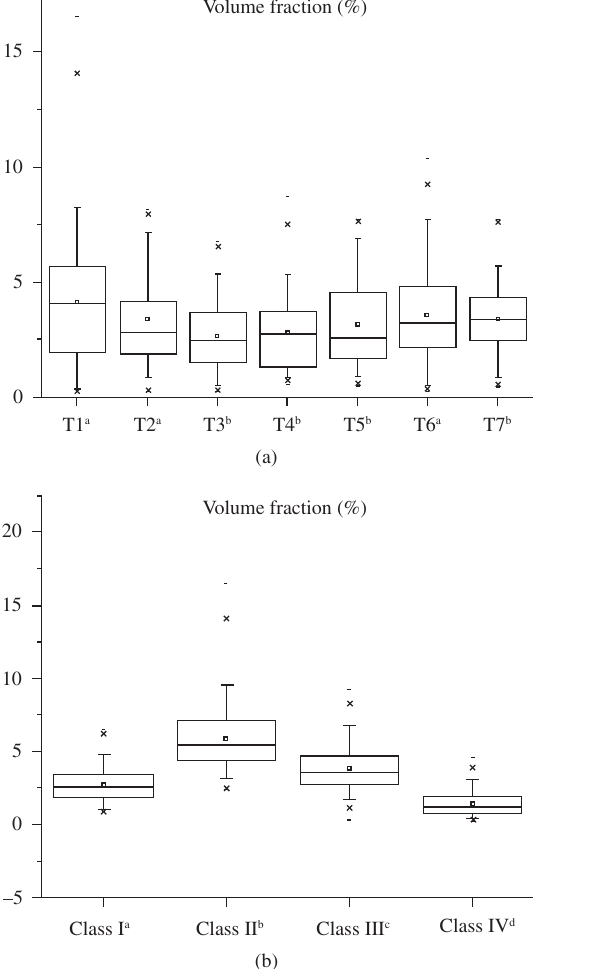
Figure 6. Area measurements: a) per tooth and b) per class of